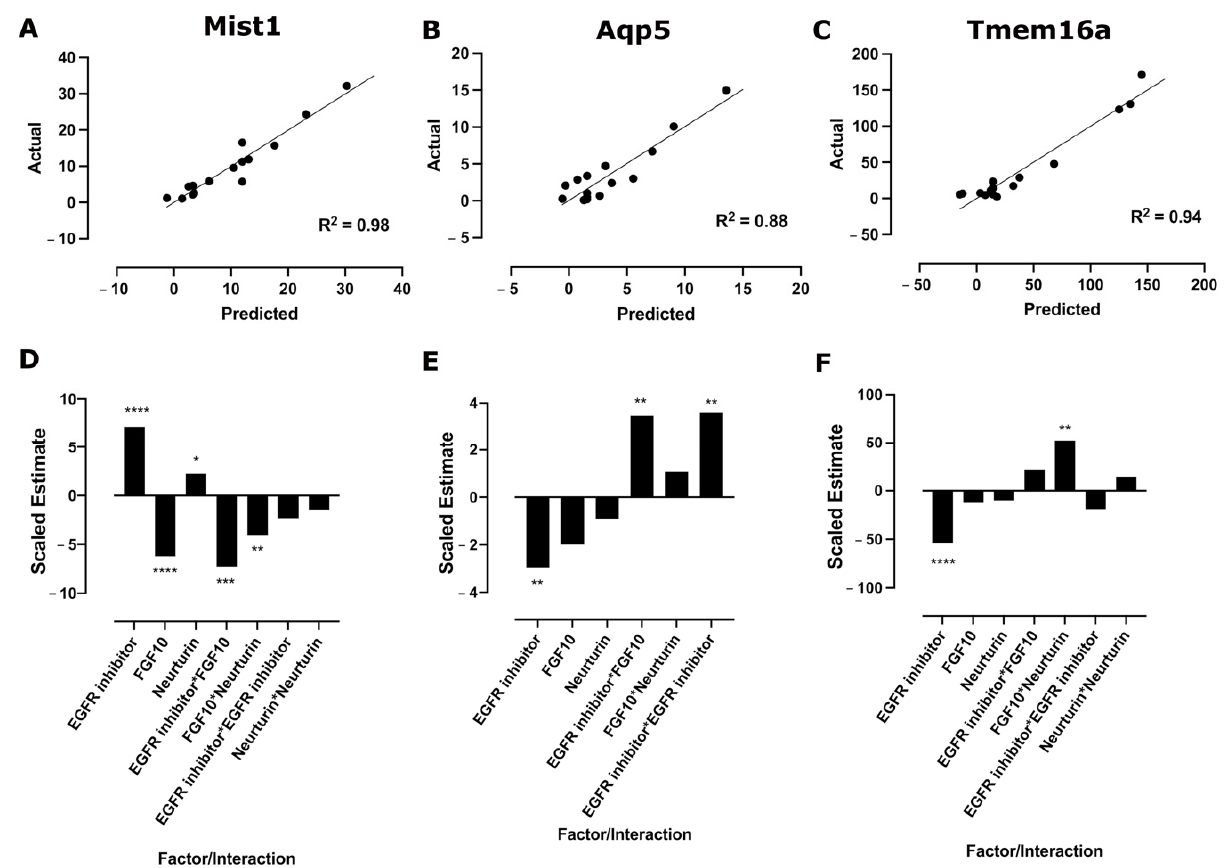
Figure 5. The EGFR inhibitor has strong positive effect on Mist1 while FGF10 and neurturin improve relative Aqp5 and Tmem16a mRNA expression. Scatter plot of the predicted (model) values against the actual (experimental) values with best fit line and R 2 values for Mist1 ( A ), Aqp5 ( B ), and Tmem16a ( C ) for the Box–Behnken DoE. Linear regression was used to determine the best fit line and R 2 values. Main effects plots showing the scaled estimates of factors and significant interactions for Mist1 ( D ), Aqp5 ( E ), and Tmem16a ( F ). p -values were determined using one-way ANOVA with Benjamini–Hochberg post-hoc test. * p < 0.05; ** p < 0.01; *** p < 0.001; **** p < 0.0001.